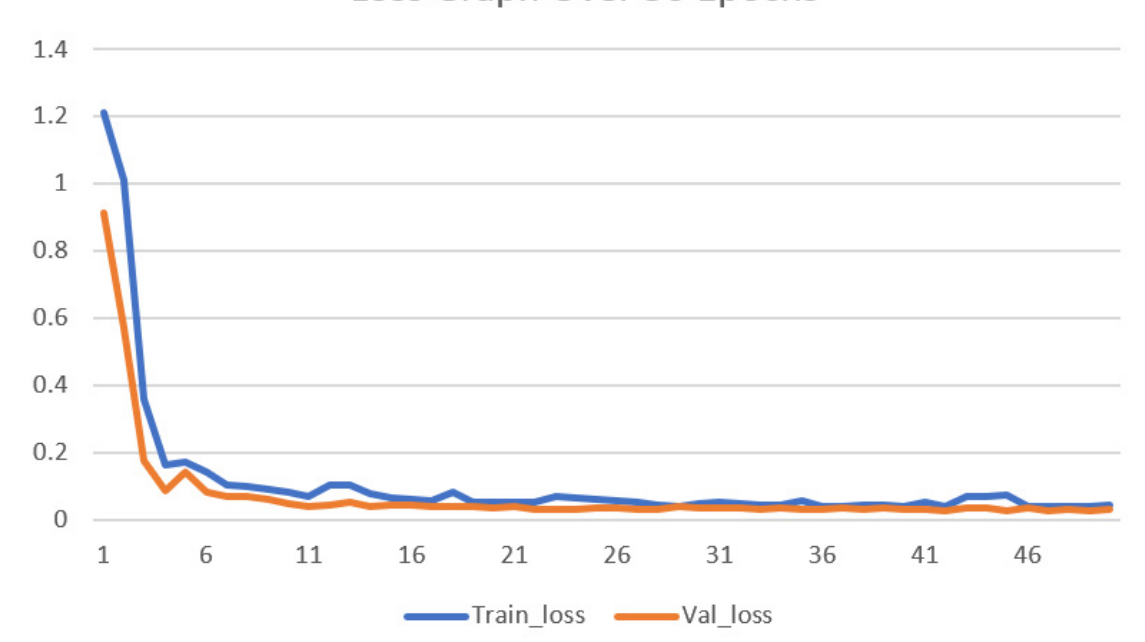
Figure 3. Loss Graph over 50 Epochs. Table 9. 1D-CNN Parameters.